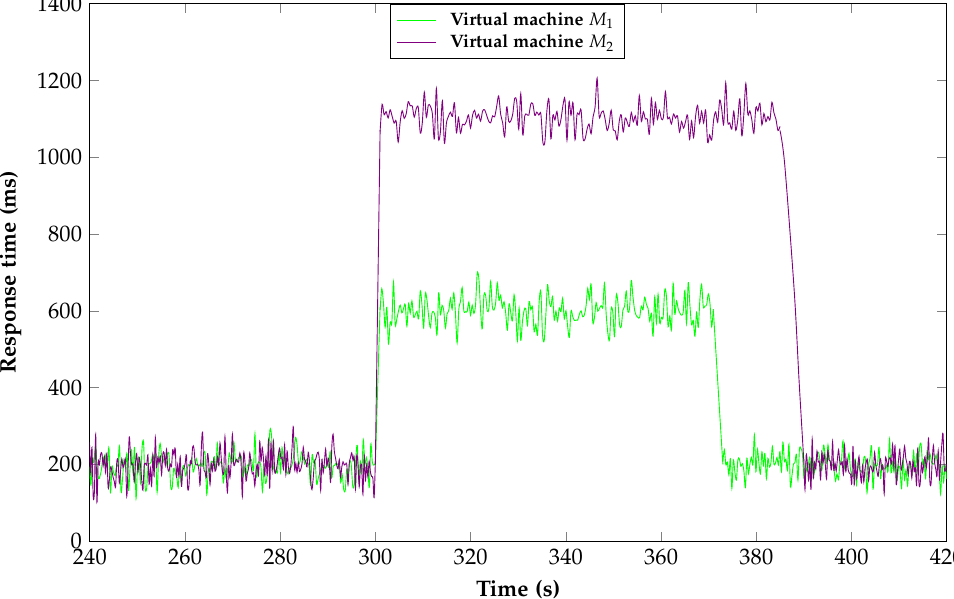
Figure 7. The response times of virtual machines M 1 and M 2 at 300